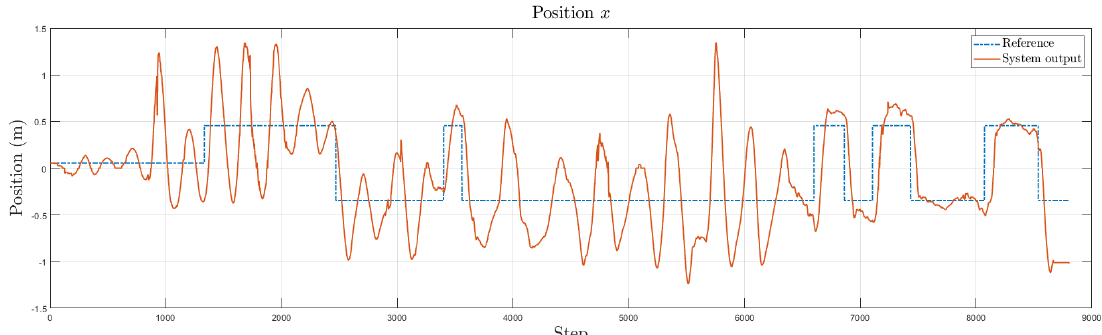
Figure 14. Experimental results for x axis changing the dynamics. Dashed line represents the reference and the solid line represents the system